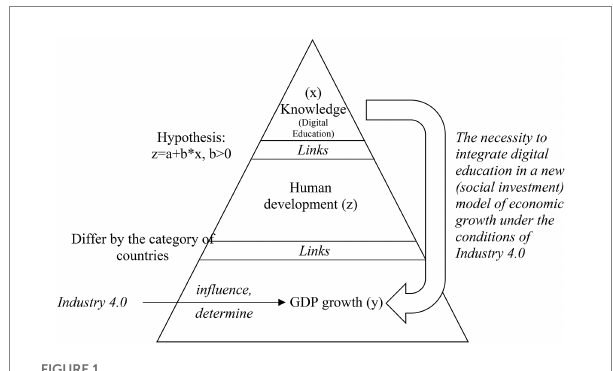
FIGURE 1 The hypothesis and logic of the study. Developed and compiled by the